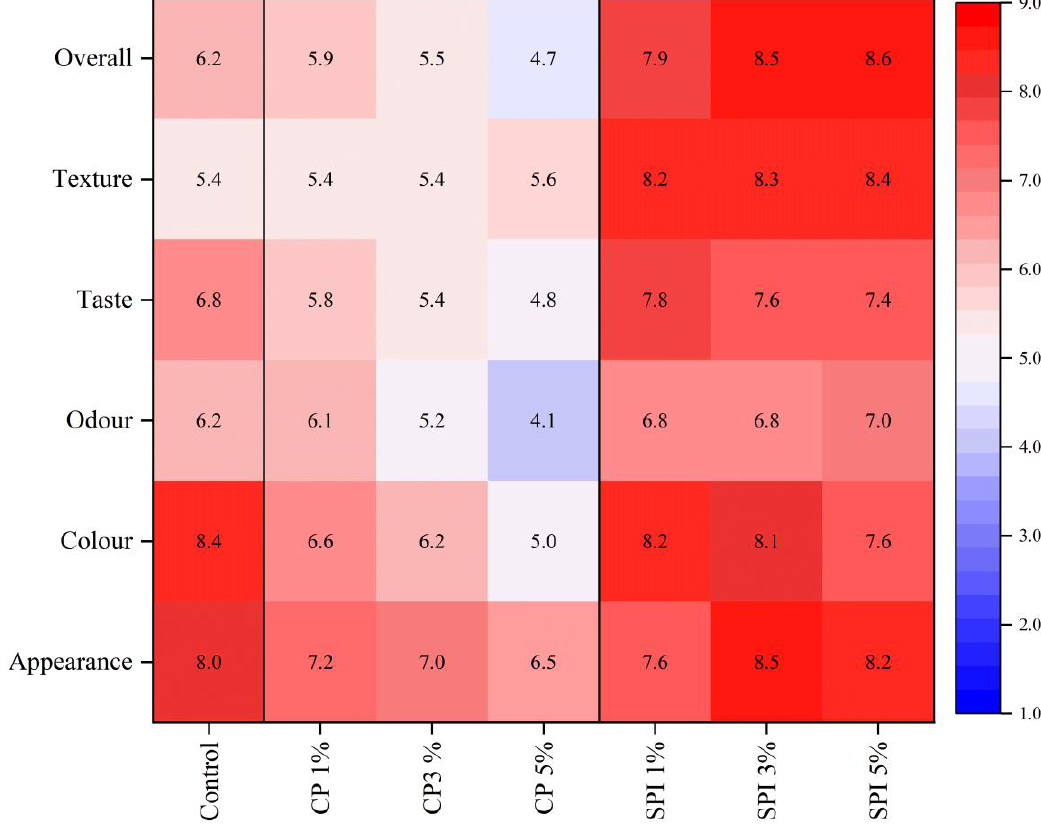
Figure 6. Heatmap of sensory properties of surimi gels with the addition of cricket powder (CP) and soy protein isolate (SPI) at different levels.